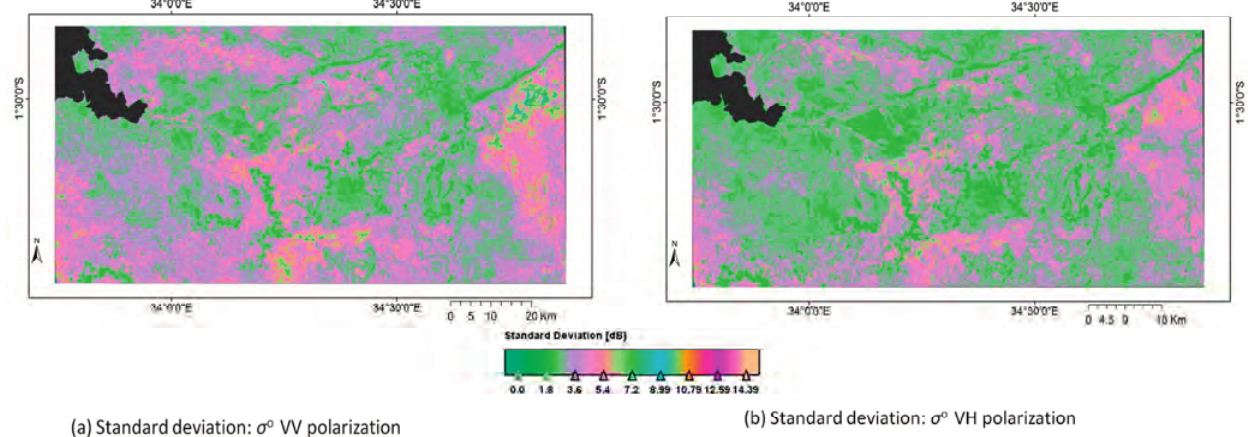
Figure 7. Standard deviation of the backscatter (in dB) for ( a ) Vertically transmitted and Vertically received signals (VV polarization) and ( b ) Vertically transmitted and Horizontally received signals (VH polarization) on the study area characterizing temporal variability of the backscatter. Areas with higher vegetation have low standard deviation than areas with shorter vegetation e.g.,